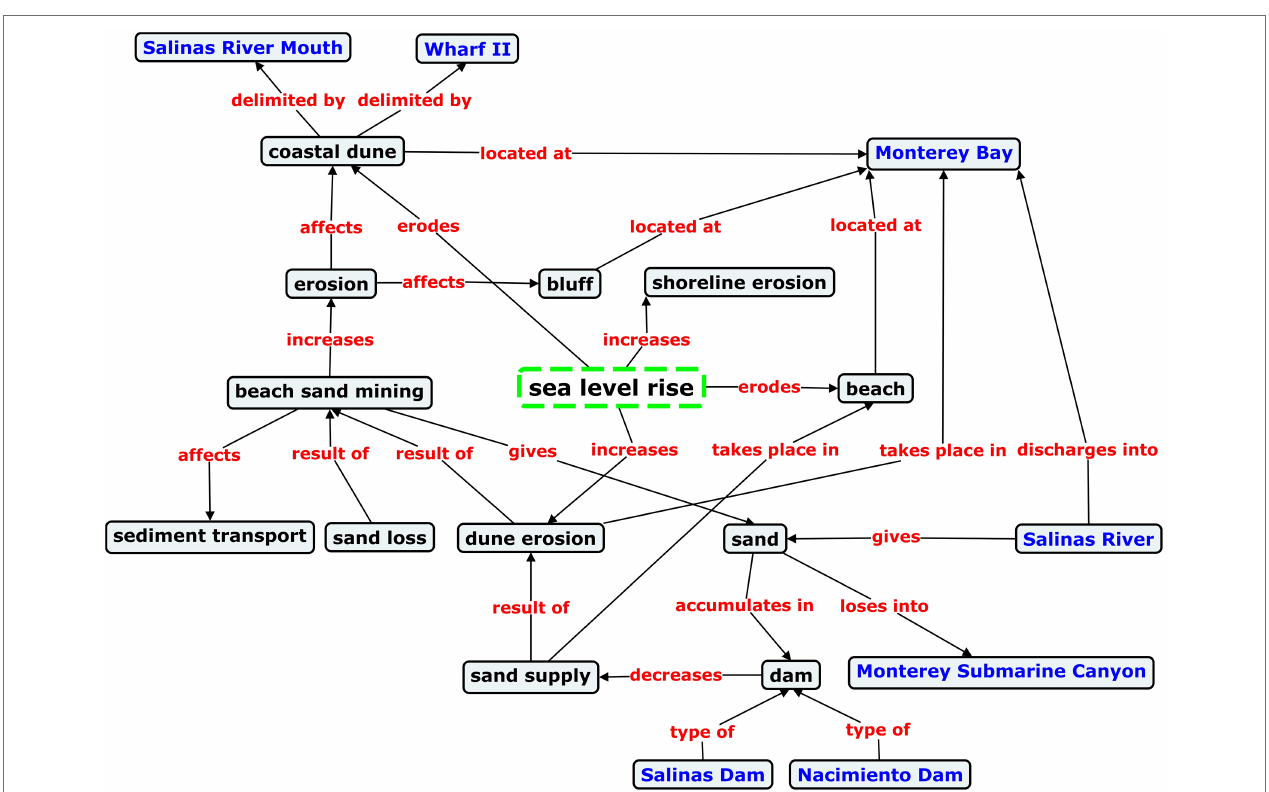
FIGURE 3 | Semantic network evoked by the Salinas River, which also serves as the geographic contextualization of the sea level rise concept in the Coastal Engineering